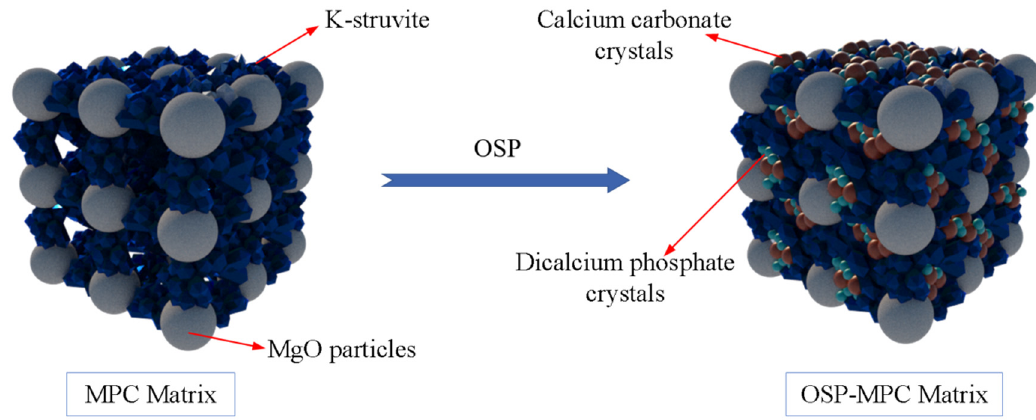
Figure 15. Reaction model of oyster shell powder–magnesium phosphate cement (OSP–MPC) matrix .